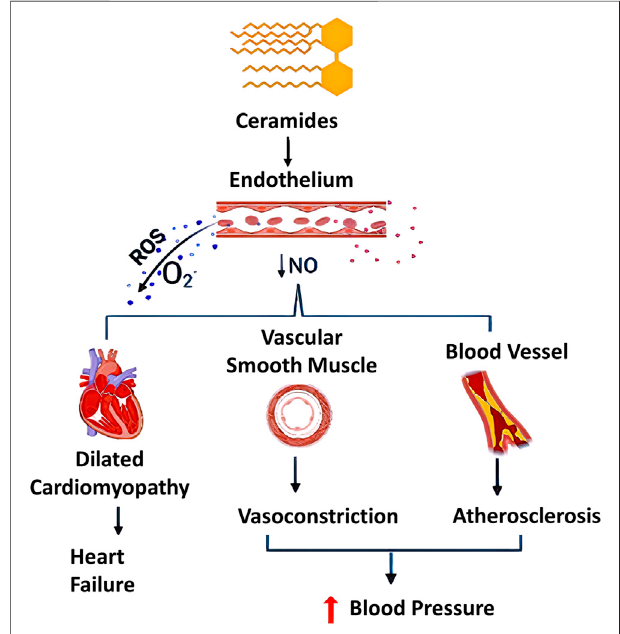
FIGURE 4 | Different pathological effects of ceramides (C16:0, C18:0, and C24:1). Effects of ceramides include generation of reactive oxygen species (ROS) and decrease in nitric oxide (NO) production, adversely affecting the human body. Ceramides showed dual effect on vascular system through uncoupling endothelial nitric oxide synthase, decreasing NO availability and sustainable stimulation of ROS production especially superoxide free radicals (O 2. − ). This may contribute to multiple dysfunctions in the cardiovascular system including oxidative stress, atherosclerosis and it can be promoted to a dilated cardiomyopathy [NO, nitric oxide synthase; ROS, reactive oxygen species]. This fi gure was created using